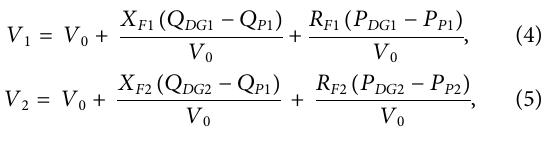
Frontiers in Energy Research |